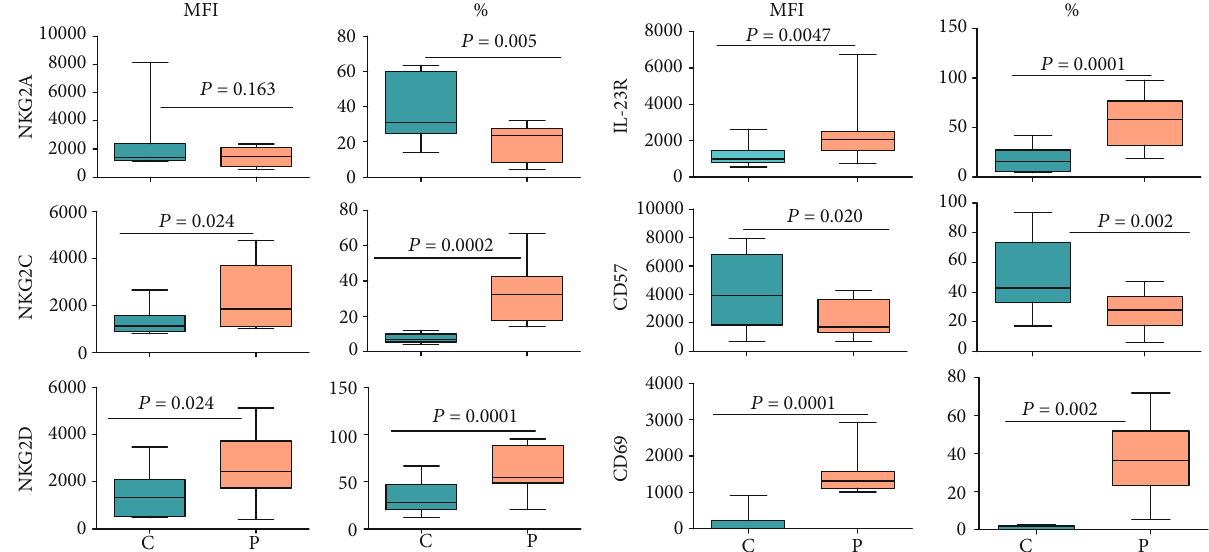
Figure 4: Expression of non-KIR markers on CD56 bright/dim NK cells in CD patients and healthy controls. The fi gure shows MFI and percentages of NK cells expressing the indicated marker in 15 treatment-naïve CD patients and 20 healthy controls. Each box and whisker plot indicates median, interquartile ranges, and p